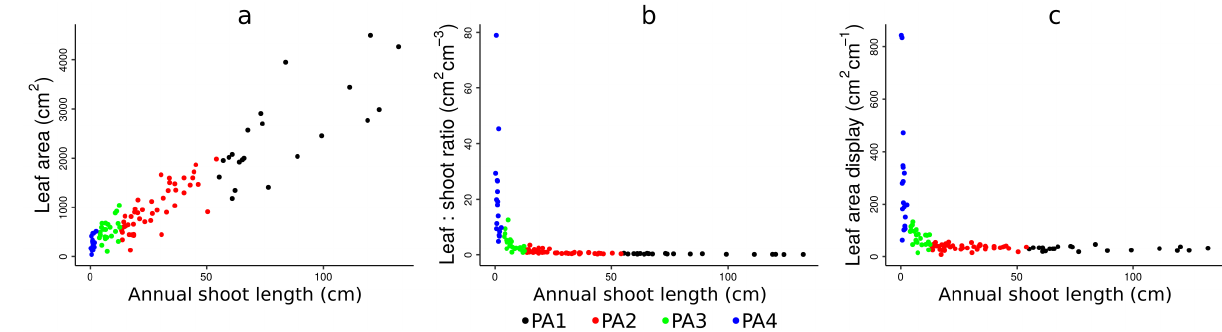
Figure 8. Manual measurement of annual shoots leaf area (( a ), τ = 0.746), leaf area:shoot volume ratio (( b ), τ = − 0.809) and leaf area display (( c ), τ = − 40.592) as a function of annual shoots length. The colours indicate the annual shoots’ physiological ages retrieved from the distribution mixture model (legend on the graph).